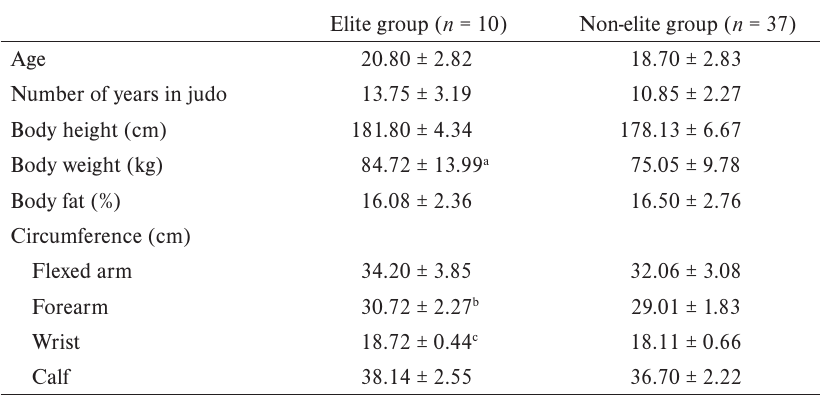
Table 2 Mean values of age, number of years in judo, body height, body weight, body fat and the circumference of flexed arm, forearm, wrist, and calf in the elite and non- elite